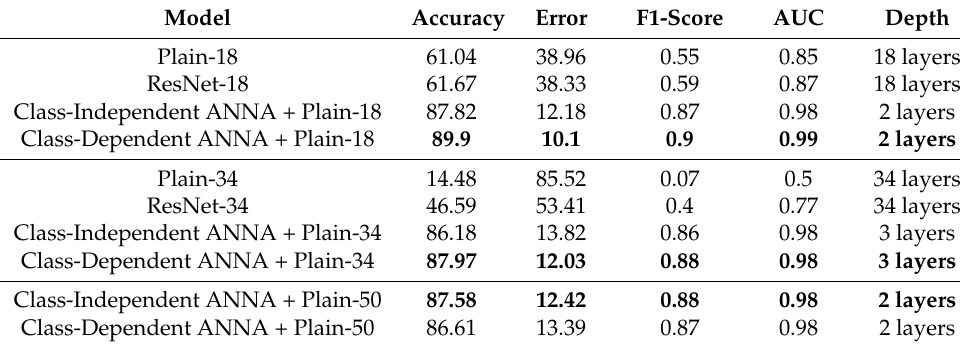
Table 3. Performance measure comparison on MNIST